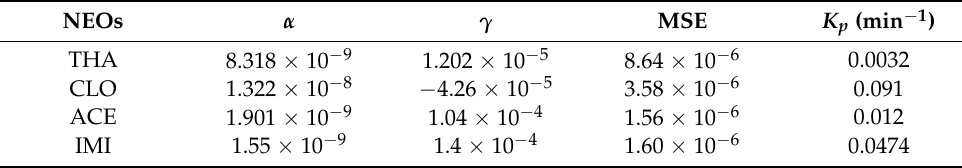
Table 2. Nlinfit-derived functions and photolysis rates of the target NEOs. NEOs